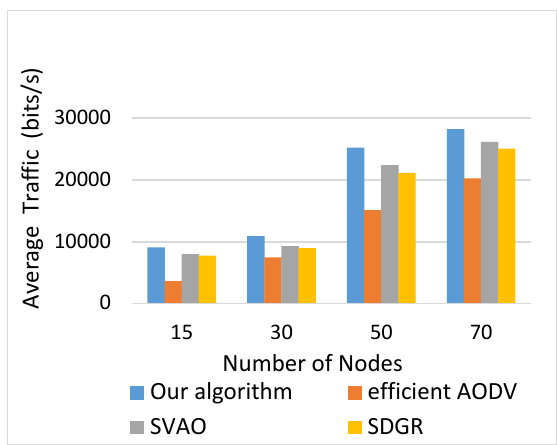
Figure 9. Average throughput.